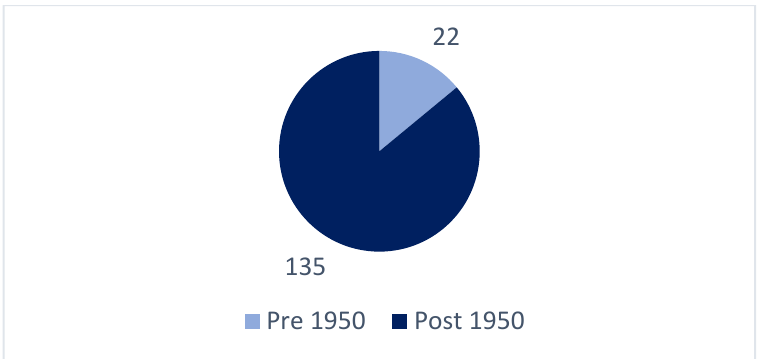
Figure 1. Distribution of water laws pre- and post-1950 .